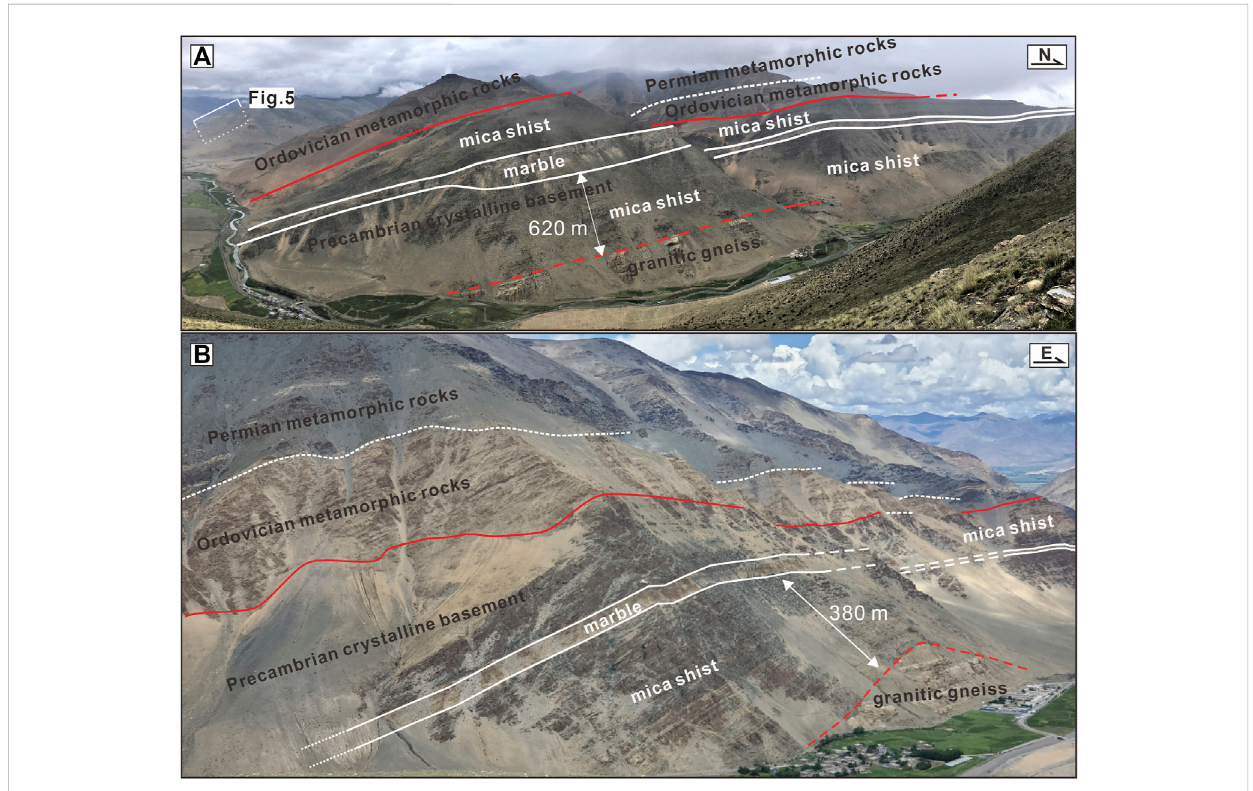
FIGURE 6 Field relationships in the Kangmar dome. (A) East-looking view of the south portion, and (B) south-looking view of the north portion. Photographs takenfromthelocationandorientationindicatedbywhiteboxesinFigure3showthatthestratasequencewascontinuous,butthedistancebetweenthe “ core-cover contact ” and marker-bed marble belt in the Precambrian basement was signi fi cantly